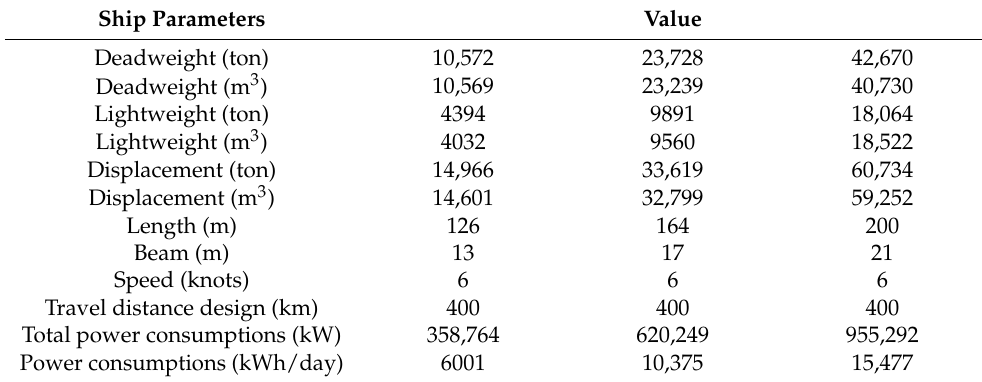
Table 8. Main parameters of final derived SST designs.